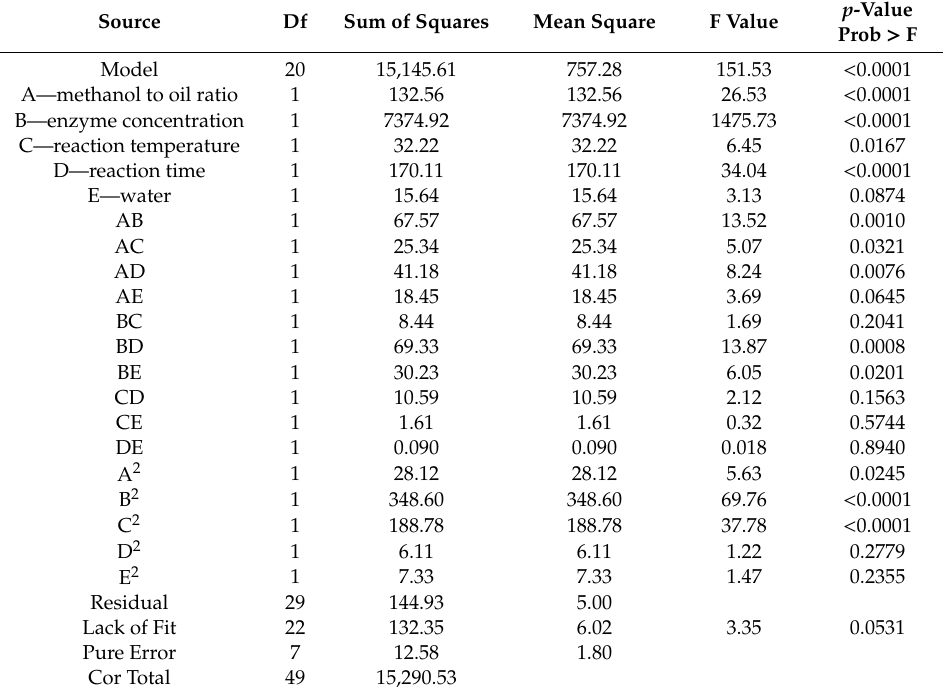
Table 2. ANOVA for response surface quadratic model for biodiesel